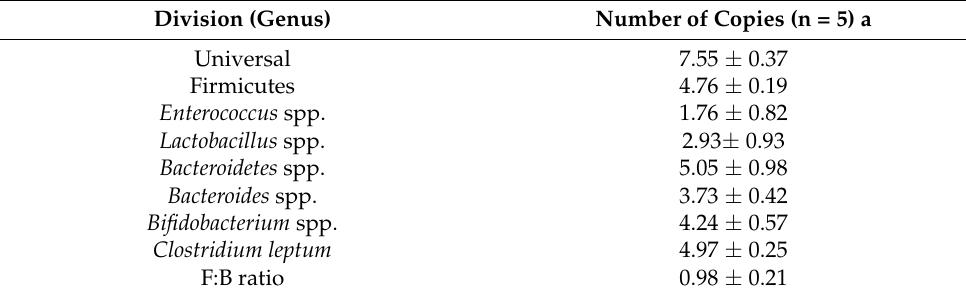
Table 4. Fecal microbiota composition of volunteer